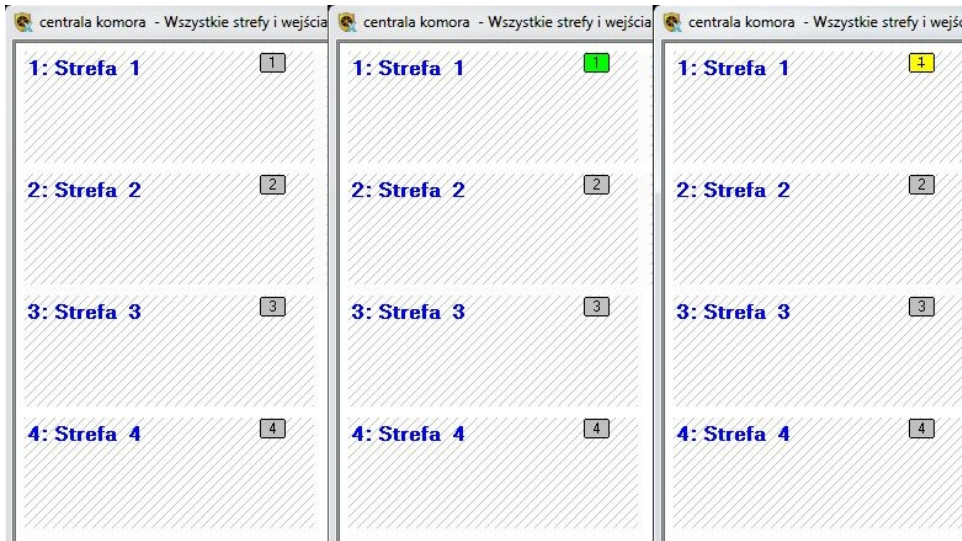
Figure 5. Visualization of the states—no violation, violation, long violation visualized via GuardX software for managing Satel alarm control panels.